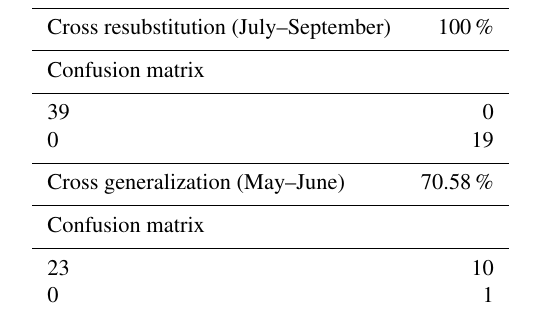
Figure 12. Scatterplot of the first and second LDA components of the SGP30 eCO 2 and TVOC outputs for cross classification of the July–September (circles) and additional May–June (triangles) cam- paigns with two classes of VILE. Table 4. Cross classification of the July–September and May–June campaigns with kNN ( k =